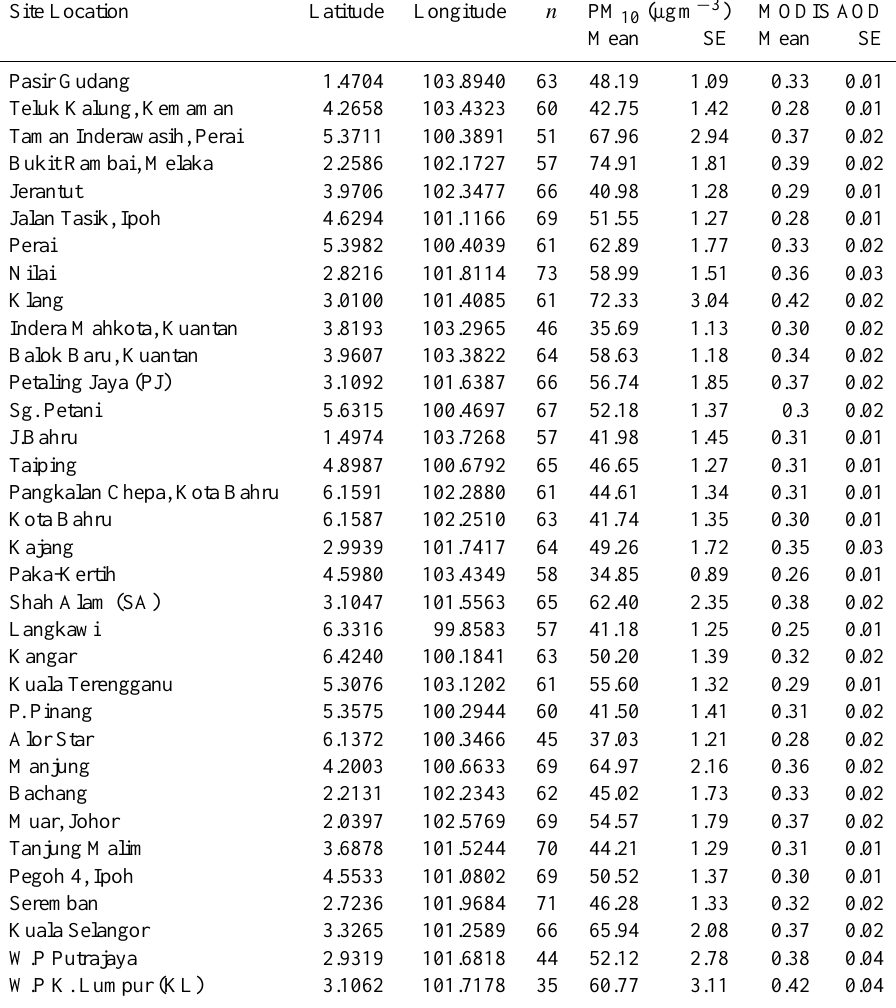
Table 1. Long-term (2001–2006) descriptive statistics of PM 10 concentration (µgm − 3 ) and corresponding MODIS AOD observed at 34 monitoring